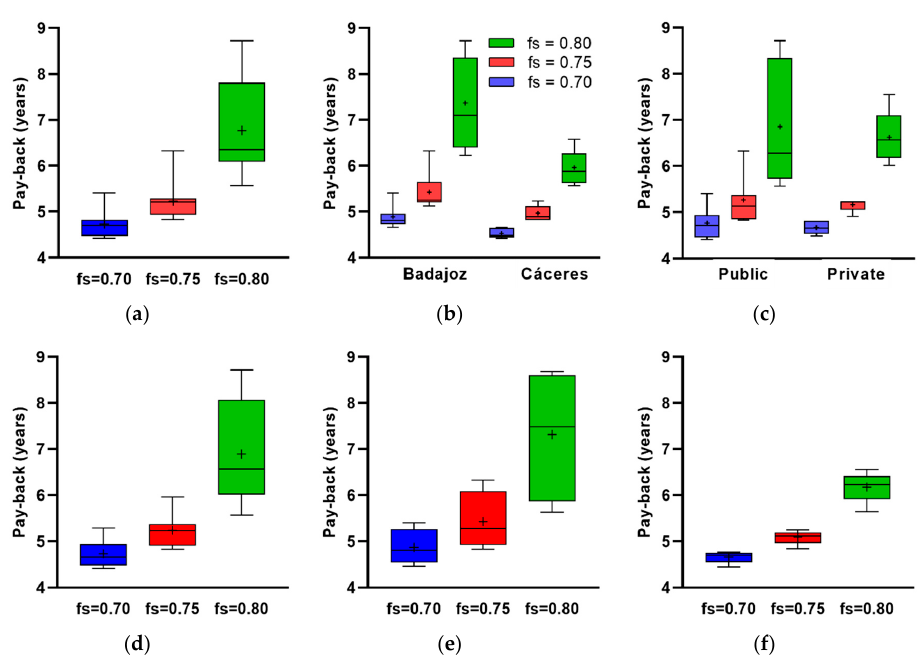
Figure 8. Payback: ( a ) global, ( b ) by province, ( c ) by type of management, ( d ) NB < 120, ( e ) 120 ≤ NB ≤ 300 and ( f ) NB > 300, according to solar